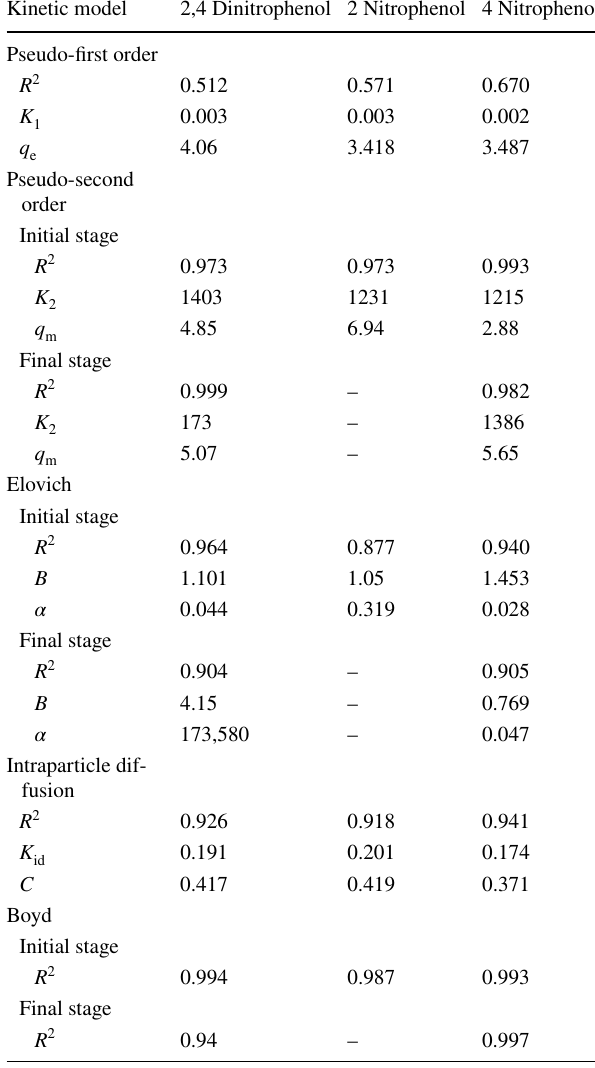
Table 5 Kinetic parameters for adsorption of phenols on char ash